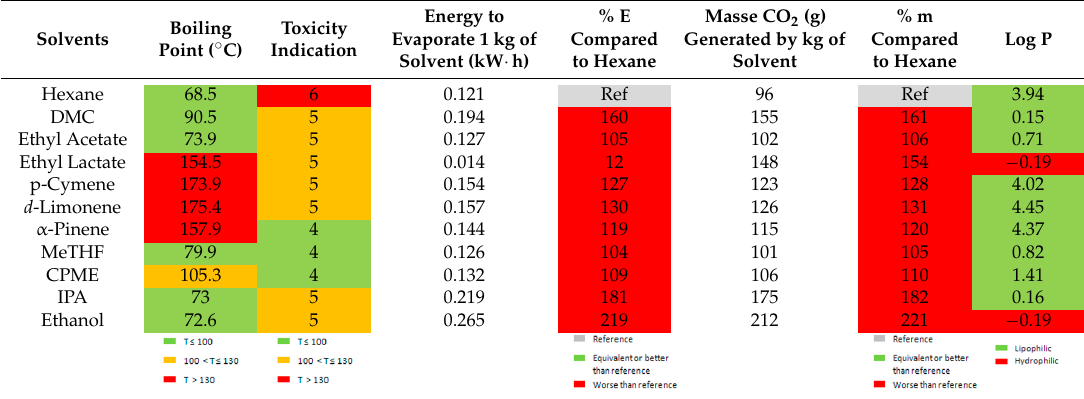
Figure 5. Structure of major lipids (FFA, DAG, TAG, PE, PC) found in yeast ( Yarrowia lipolytica ).